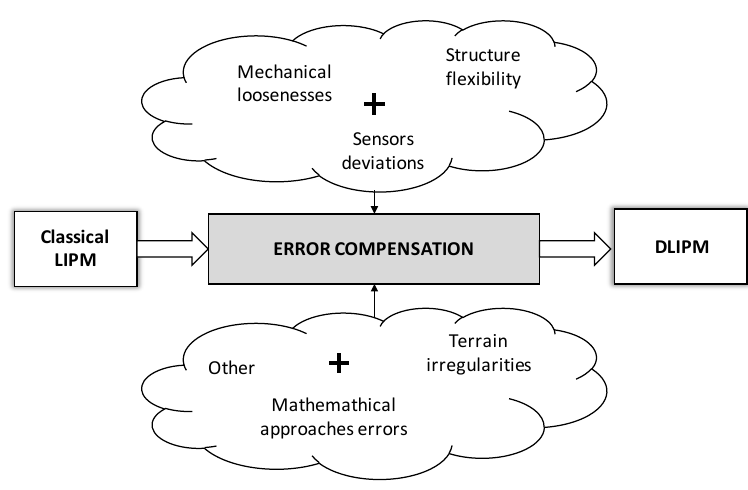
Figure 10. Error compensation diagram. From classical LIPM to new DLIPM.